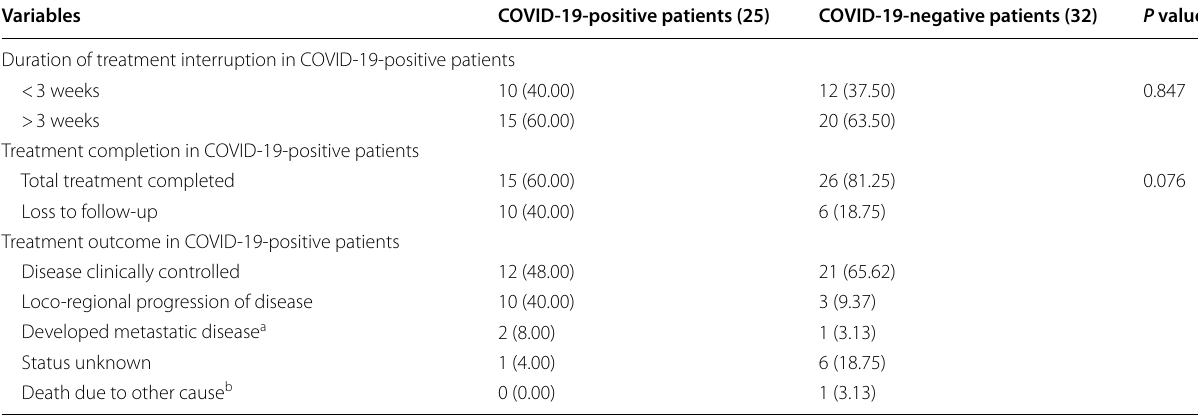
Table 3 Treatment interruption and treatment outcome in COVID-19-positive and COVID-19-negative